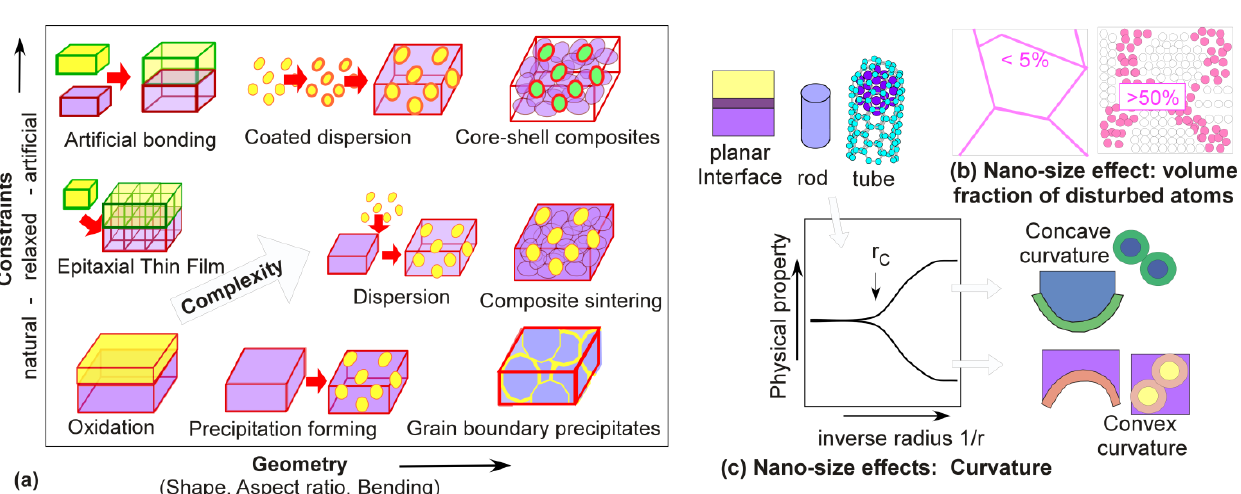
Figure 3. ( a ) Increasing complexity of interfaces in a schematic diagram of geometrical features and constraints; ( b , c ) Nano-size effects of properties due to interfaces: ( b ) volume fraction of disturbed atoms; ( c ) curvature of interfaces.